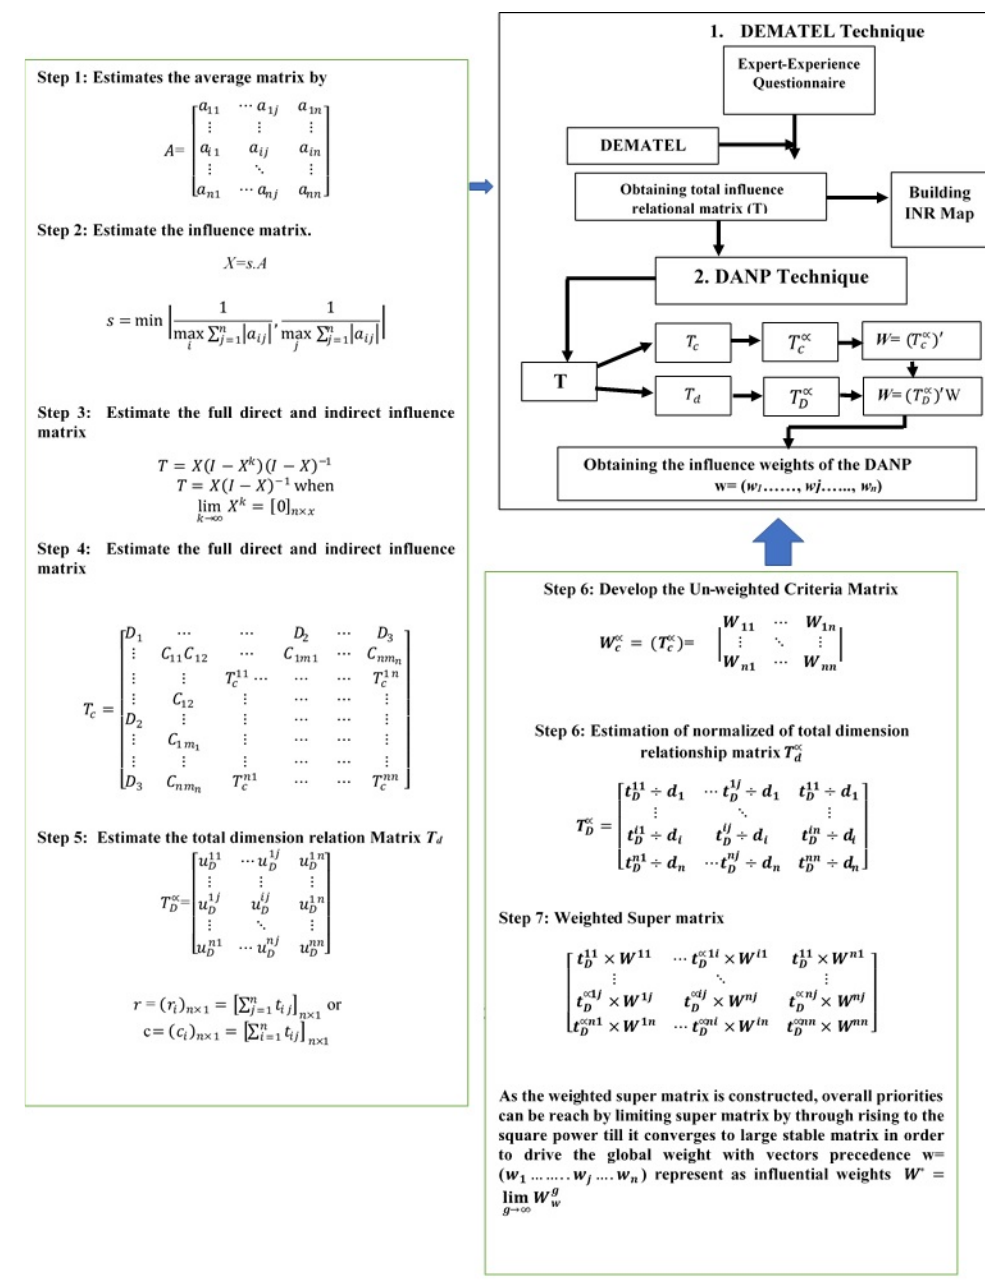
Figure 4. Complete steps of DANP methods.